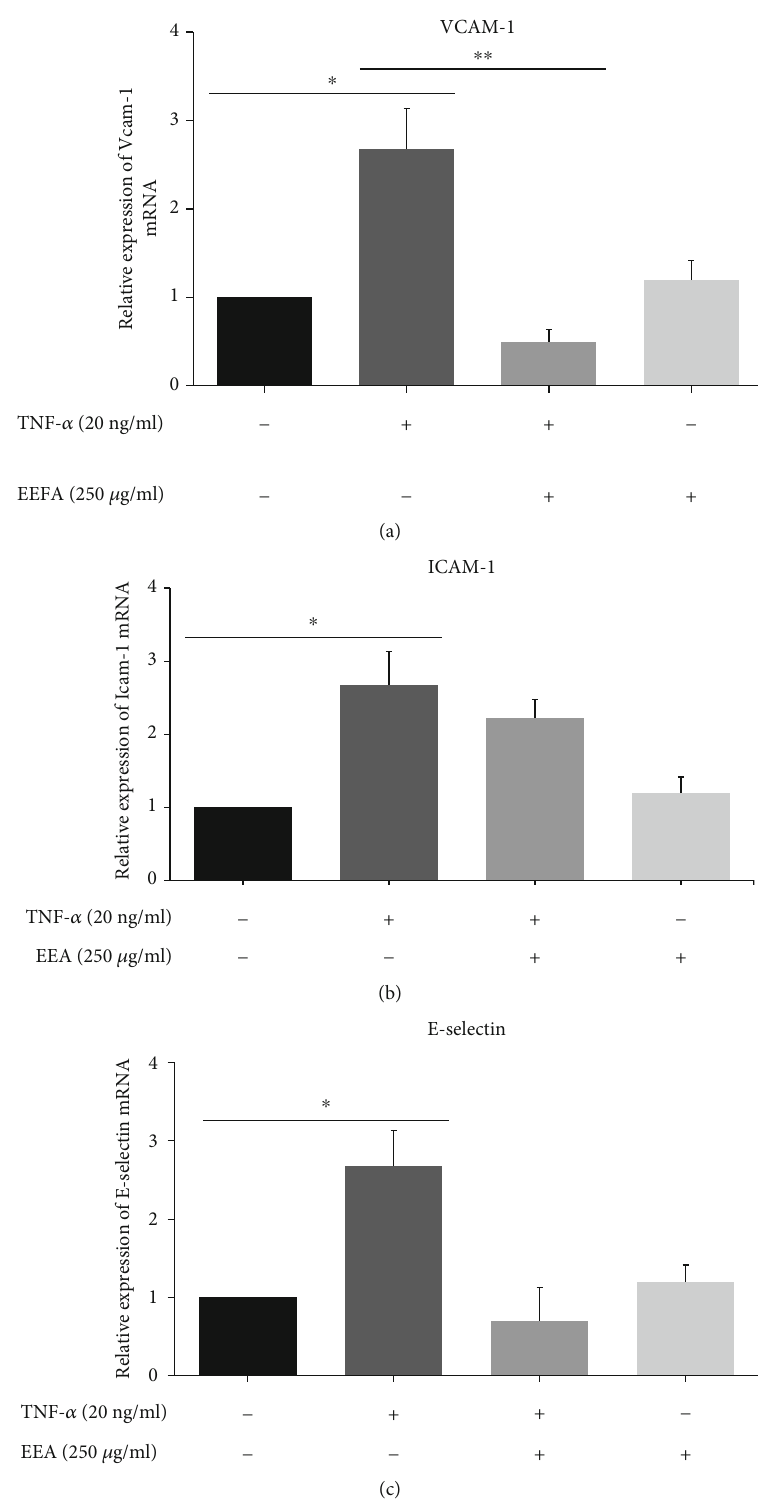
Figure 3: Impact of EEA on ECAM expression in HUVECs activated by TNF- α through real-time PCR. (a, b, c) TNF- α (20 ng/ml) across 12h raises VCAM-1, ICAM-1, and E-selectin expression. TNF- α -induced expression of VCAM-1, ICAM-1, and E-selectin decreased with 250 μ g/ml of EEA for 6 h, but this reduction was not statistically meaningful except in the expression of VCAM-1. Numbers are presented as a normalised VCAM-1, ICAM-1, and E-selectin mRNA to β -actin mRNA, schemed in bar diagrams, and have been shown as mean ± S : D : ∗ p ∗∗ p < 0 : 01 concerning the control group and < 0 : 001 relatives to the TNF- α -treated group that were calculated by one-way ANOVA